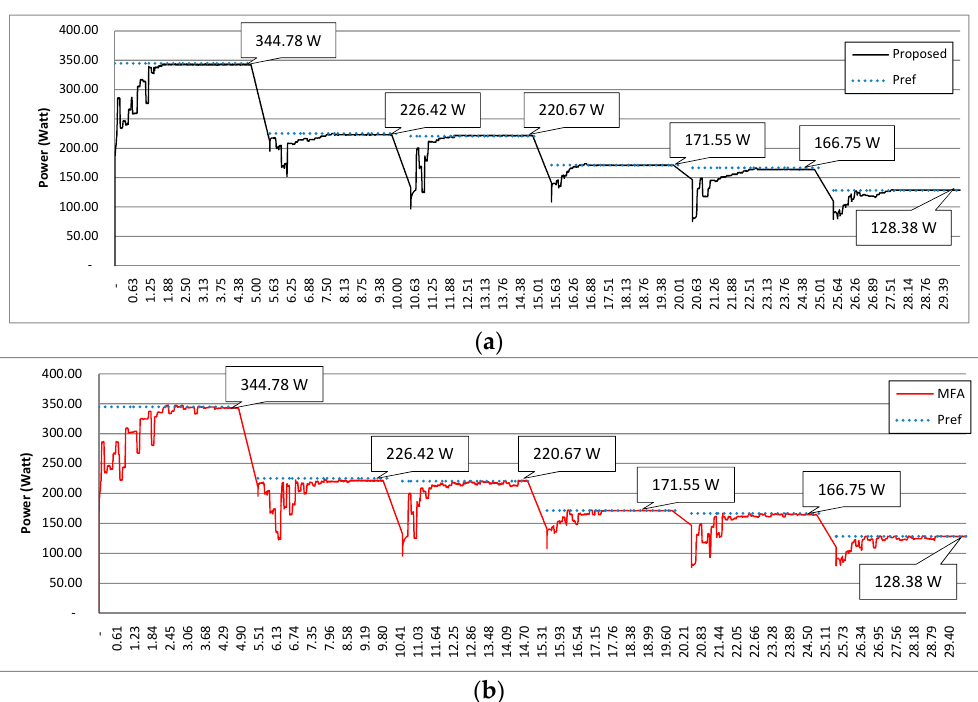
Figure 13. Shaded pattern changing sequence.